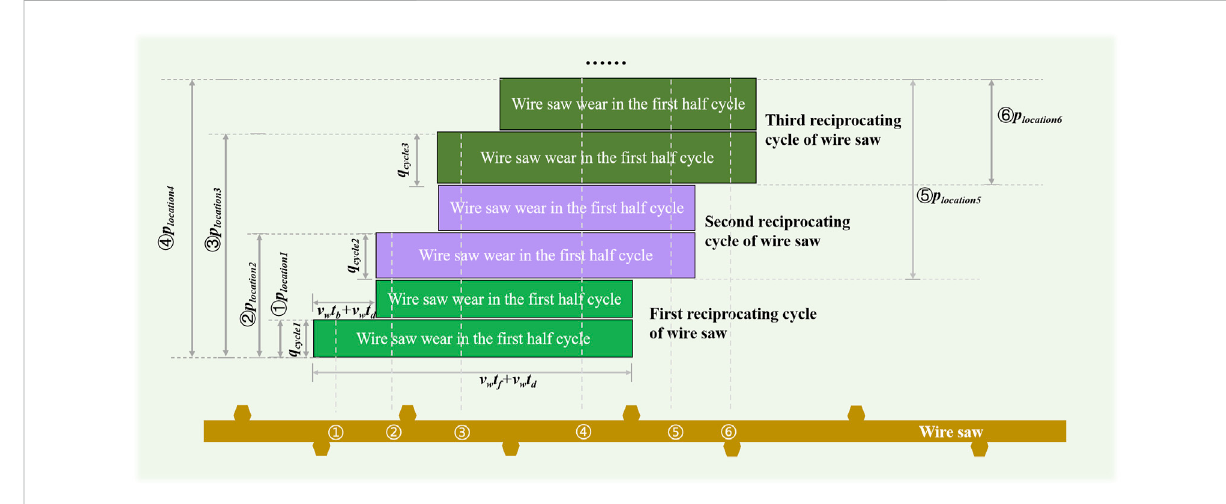
FIGURE 5 Wire movement and wear distribution of wire saw in multiple reciprocating cycles.